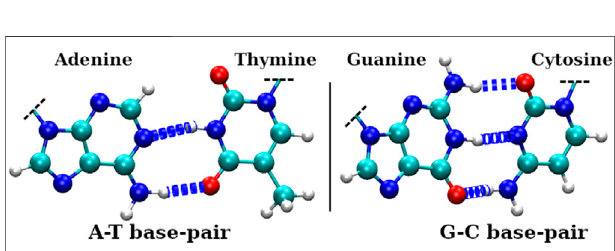
FIGURE 3 | H-bonds involved in Watson-Crick (WC) base pairs of dsDNA, where left panel shows H-bonds between adenine(A) and thymine(T) bases and the right panel shows H-bonds between guanine(G) and cytosine(C) bases. The larger dark silver spheres, smaller bright silver spheres, blue spheres, and red spheres represent carbon, hydrogen, nitrogen, and oxygen atoms,